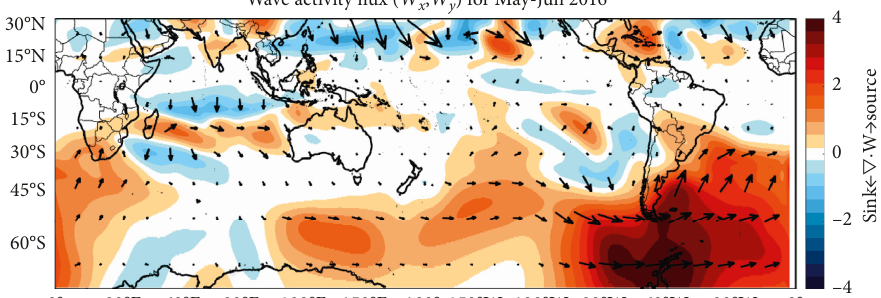
Figure 9: Wave activity flux ( 10 6 ) for May-Jun 2016. The arrows represent the wave flux W x and W y , and the shading represents the wave × flux divergence, wave flux divergence indicates Rossby wave sources and convergence indicates Rossby wave sinks. Following Takaya and Nakamura [59], the wave flux is parallel to the phase velocity of the Rossby wave packages.